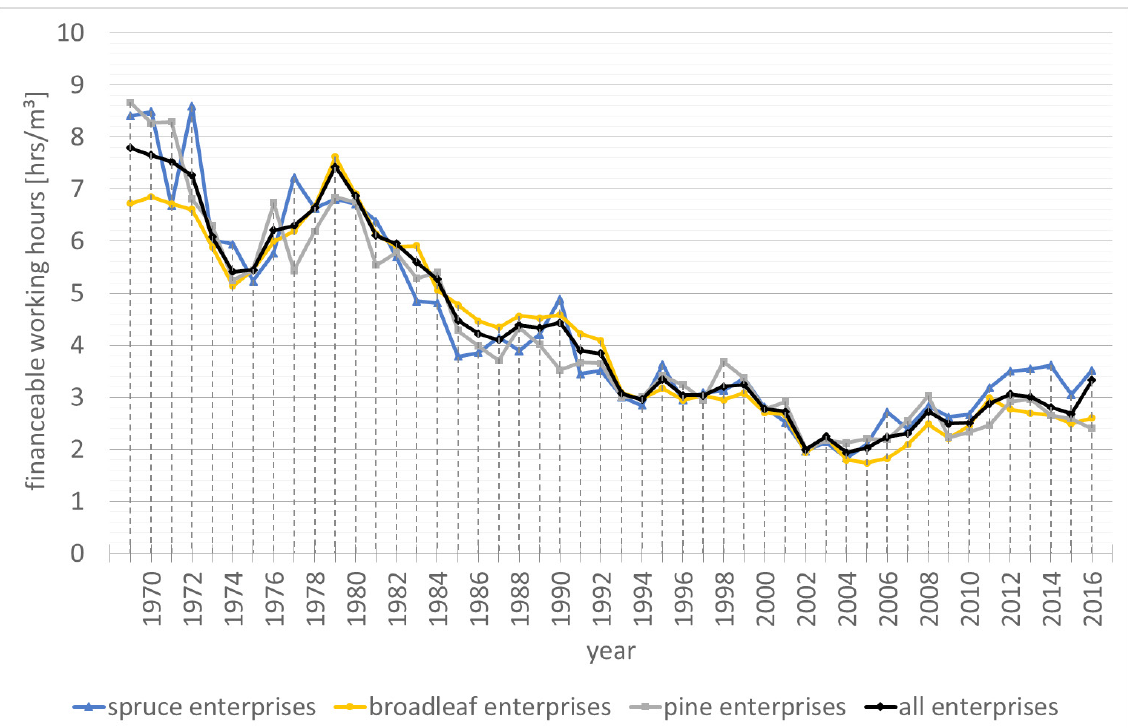
Figure 4: Financeable working hours according to consultancy